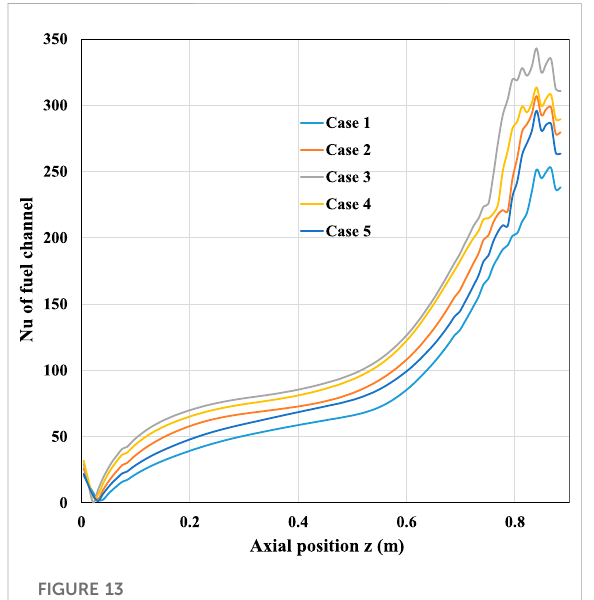
FIGURE 14 Axial distribution of the Nusselt number in the return channel considering different Reynolds numbers and heat